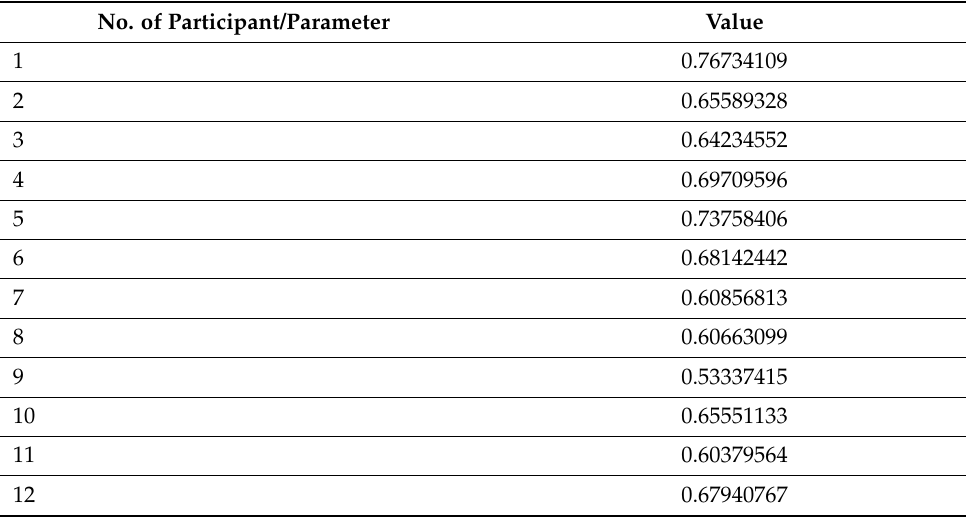
Table 3. Fuzzy model outcomes for studied Group